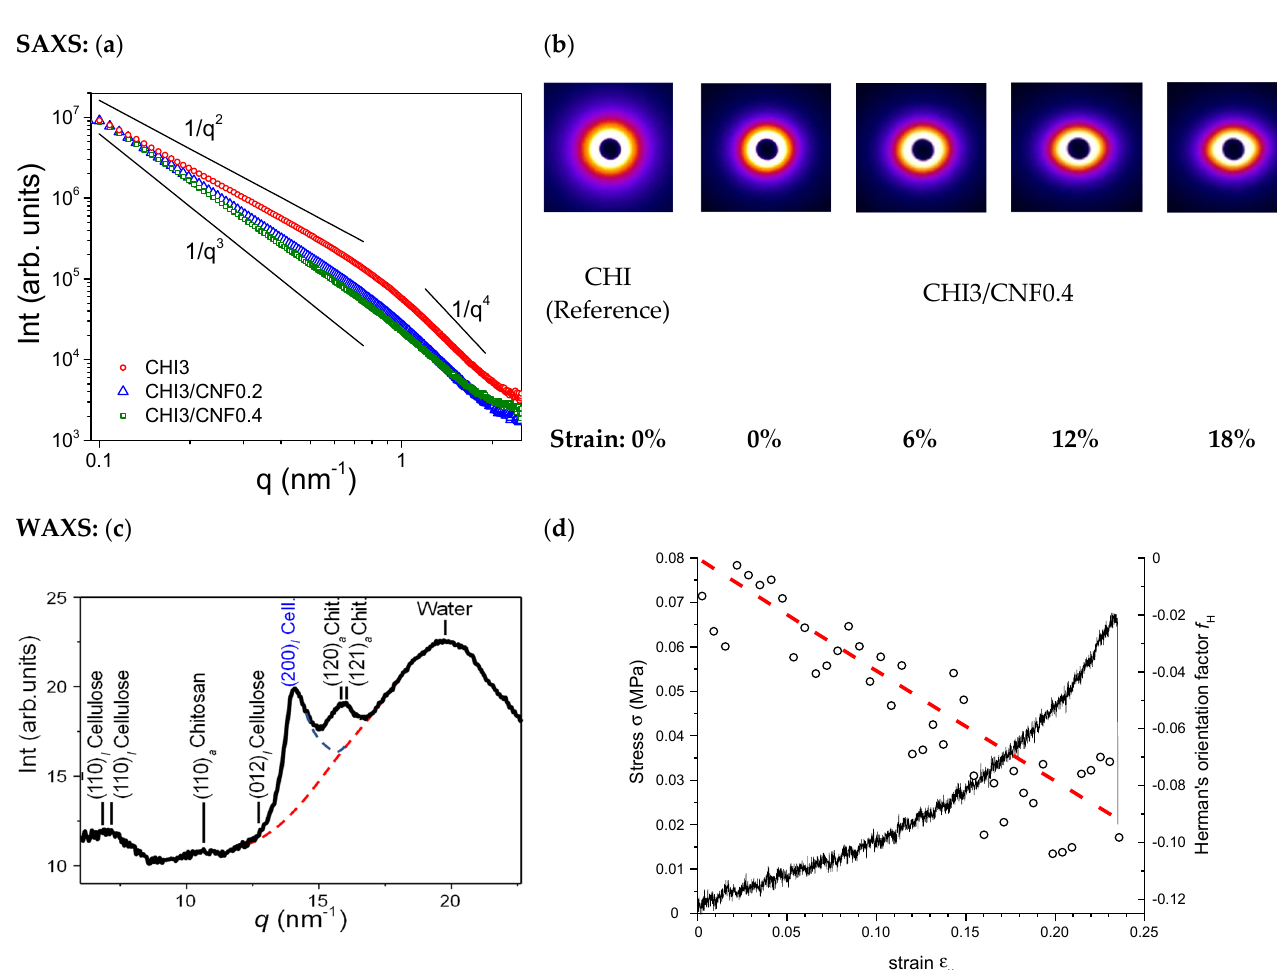
Figure 6. ( a ) Synchrotron small-angle X-ray scattering (SAXS) radial average curves of the CHI/CNF printed hydrogel filaments; ( b ) 2D SAXS image patterns recorded for different strains after stretching the CHI3/CNF0.4 printed hydrogel formulation, with printed CHI hydrogel reference included. ( c ) Synchrotron wide-angle X-ray scattering (WAXS) radial average of printed CHI3/CNF0.4 hydrogel composite, for example, after 14% of tensile strain; ( d ) Evolution of the Herman’s orientation factor f H estimated from the azimuthal intensity plots of the (200) I reflection of cellulose I (fitted with Lorentz function) at different strain values during in situ uniaxial stretching (rate: 1 μ m/s, RH: 45%) using X-ray synchrotron radiation, for the CHI3/CNF0.4 printed hydrogel. The red dashed-line in ( d ) shows the CNF orientation distribution function obtained by the affine model used for reorientation of rigid rod-like crystals [95,96].